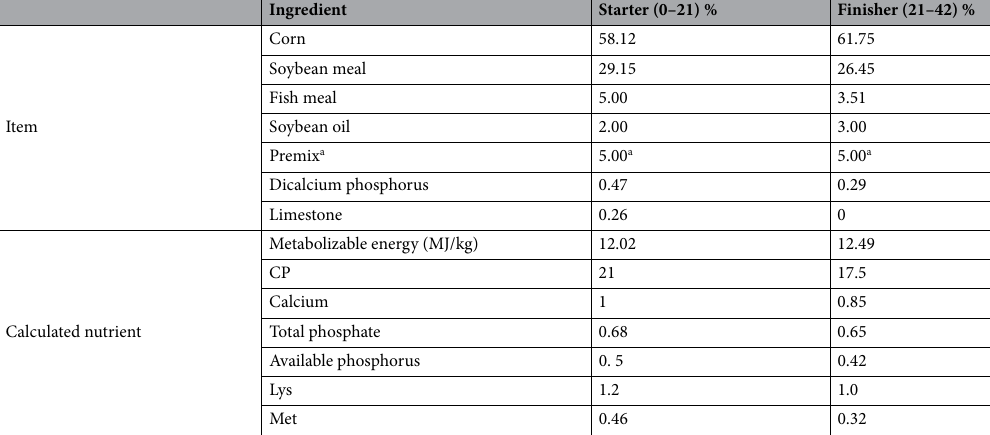
Table 1. Nutrient analysis of the basal diet. The premix provides, a Vitamins and trace elements per kg diet: Vitamin A (retinyl acetate) 9, 875 IU, Vitamin D 3 (cholecalciferol) 3, 000 IU, Vitamin E (dl- ɑ -tocopheryl acetate) 20 IU, menadione 3.25 mg, Vitamin B 12 (cyanocobalamin) 0.025 mg, thiamin 1.5 mg,